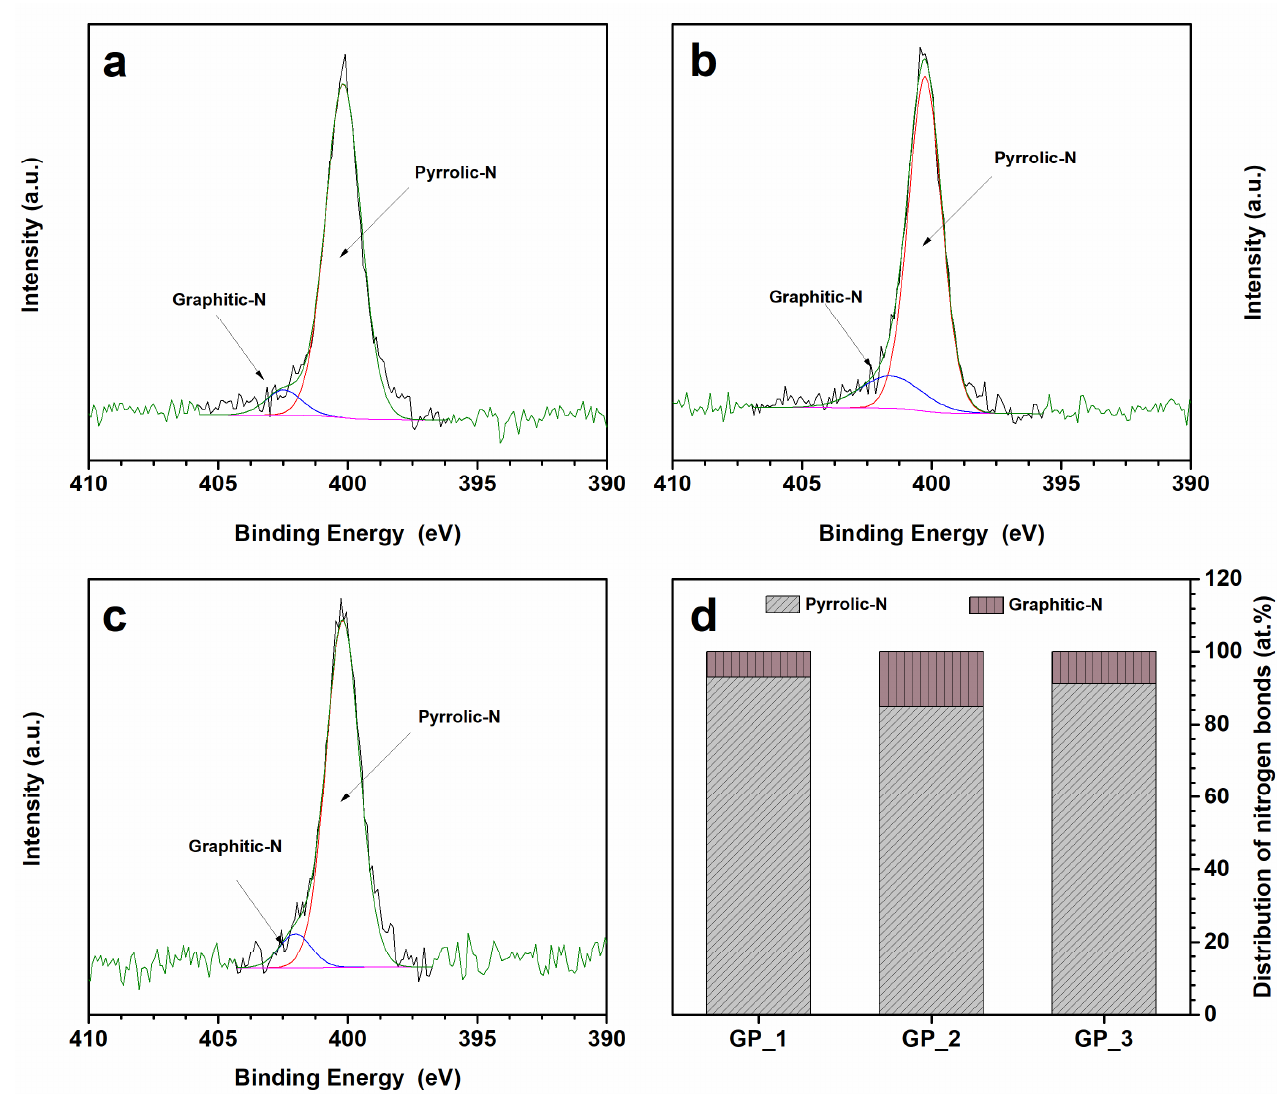
Figure 6. N 1s XPS spectra of nanocomposite GP samples: GP_1 ( a ), GP_2 ( b ), and GP_3 ( c ). Distribution of nitrogen bonds in GP samples ( d ).